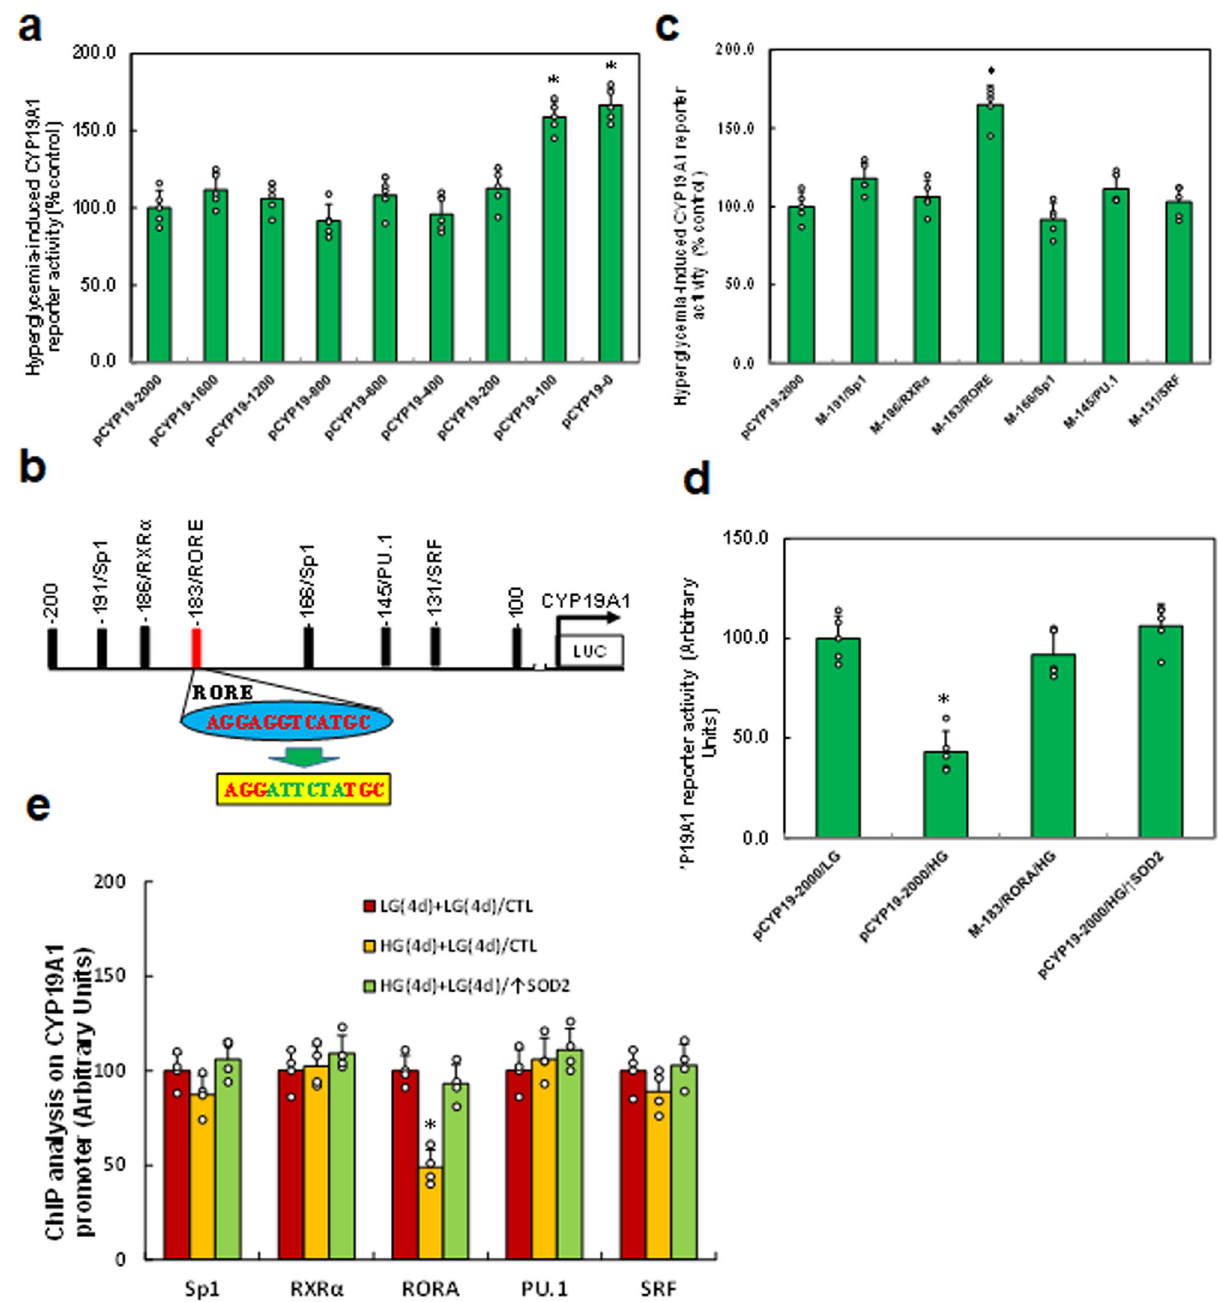
Fig. 3 Hyperglycemia induces CYP19A1 suppression through RORA dissociation from the RORE response element on the CYP19A1 promoter. a The conditional immortalized ACS-5003 neurons were transiently transfected with either CYP19A1 full length (pCYP19-2000) or deletion reporter plasmids. After 24 h, the cells were treated with either 5 mM low glucose (LG) or 25 mM high glucose (HG) for 3 days and the relative CYP19A1 reporter activities were calculated n = 5. *, P < 0.0001, vs. pCYP19-2000 group. b The schematic picture for the potential transcriptional binding motif in the range of − 200 to 100 (from transcription start site) on the CYP19 promoter with one potential RORA response element (RORE) marked in red as well as related mutation site marked in green. c The cells were transiently transfected by either a wild-type CYP19 reporter construct (pCYP19-2000) or single point mutation at the site shown in ( b ), and then treated with either LG or HG for 3 days, and the CYP19A1 reporter activities were calculated n = 5. *, P < 0.0001, vs. pCYP19-2000 group. d The cells were transiently transfected by CYP19A1 full length (pCYP19-2000), single mutant, or infected by SOD2 lentivirus ( ↑ SOD2), and then treated with either LG or HG for 3 days; the CYP19A1 reporter activities were then calculated, n = 5. *, P < 0.0001, vs. pCYP19A1-2000/ LG group. e Cells were treated with either 4-day LG plus 4-day LG (LG(4d) + LG(4d)), or 4-day HG plus 4-day LG (HG(4d) + LG(4d)), or infected on day 4 by SOD2 lentivirus (HG(4d) + LG(4d)/ ↑ SOD2); the cells were then used for ChIP analysis by potential transcription factors on the CYP19A1 promoter, n = 4. *, P < 0.0001, vs. LG(4d) + LG(4d)/CTL group. Data were expressed as mean ± SEM.